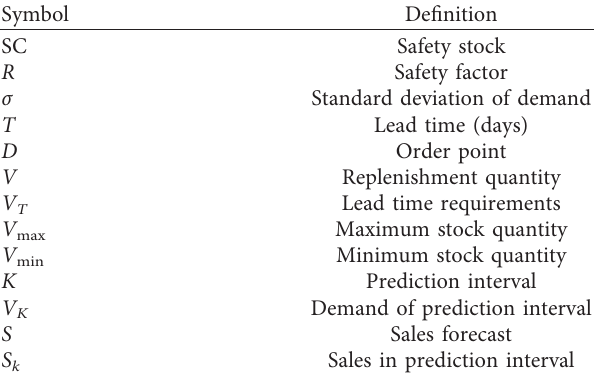
Table 1: Symbol definitions for the replenishment decision